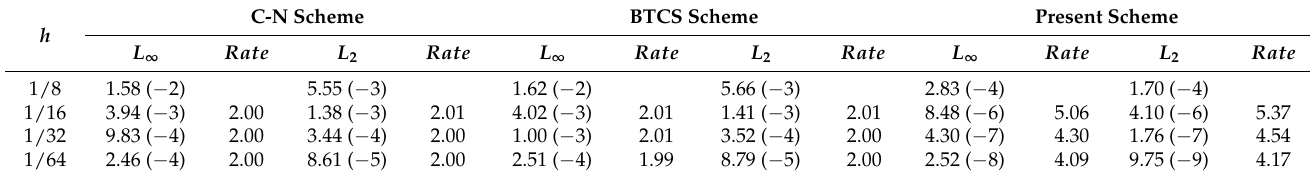
Table 7. The L ∞ error, L 2 error and convergence rate when h = 0.03125, T = 0.5 for Problem 4.